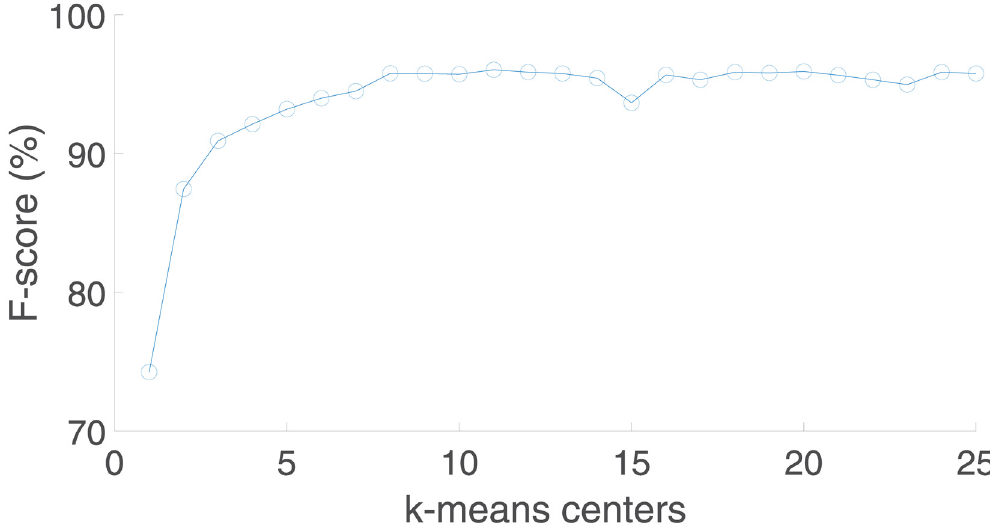
Fig 11. Evolution of F-score with respect to the number of k-means clusters for the hand gesture recognition.